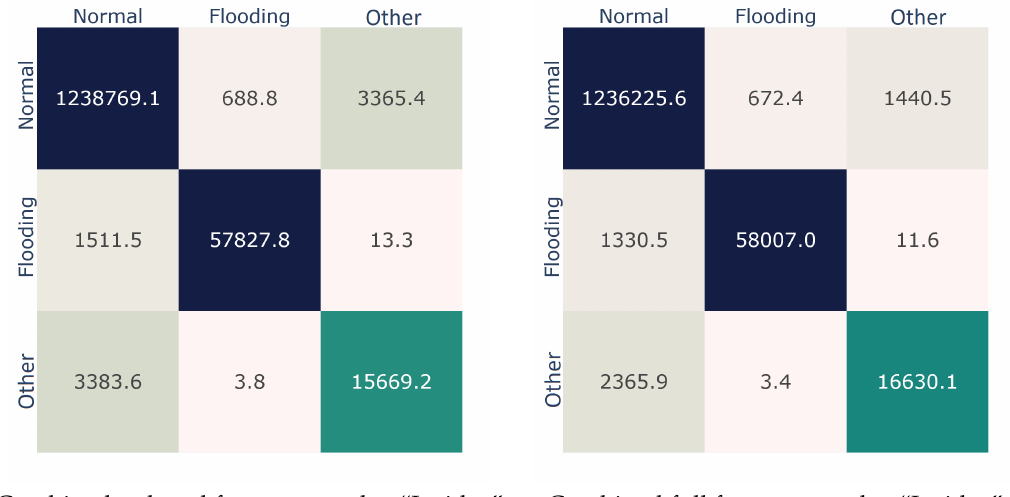
Figure 7. Best performer (Bagging) confusion matrices considering the engineered